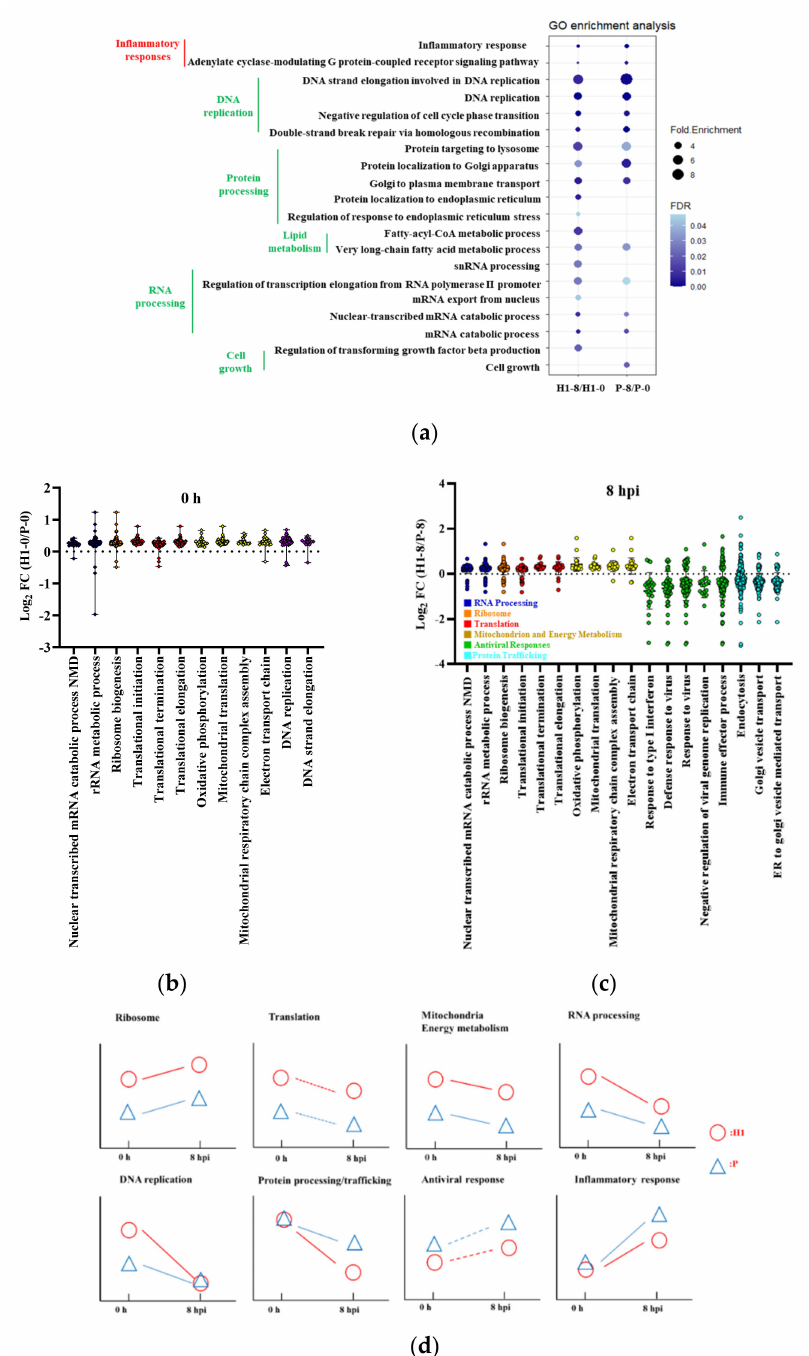
Figure 4. Dynamics of cell response to IAV infection. ( a ) Gene ontology enrichment analysis of host responses of H1 and P upon IAV infection; size represents the fold enrichment, color represents the FDR. Colors of clustered GO terms represents direction of change—red: up − regulated, green: down − regulated. ( b ) transcript ratio of H1 to P in enriched functional classes at 0 h. ( c ) transcript ratio of H1 to P in enriched functional classes at 8 hpi. ( d ) dynamics of enriched functional classes in IAV infection. The relative positions of H1 (red circle) and P (blue triangle) at 0 h and 8 hpi were located according to the GESA results in Figure 4( b , c ) and Table S4. The dynamic changes from 0 h to 8 hpi were inferred either from the transcriptome analysis results (solid line) from GO and GSEA enrichment in Figure 4 a and Tables S2 and S3, or by inference (dashed line). Samples from triplicated infections were used for RNAseq data